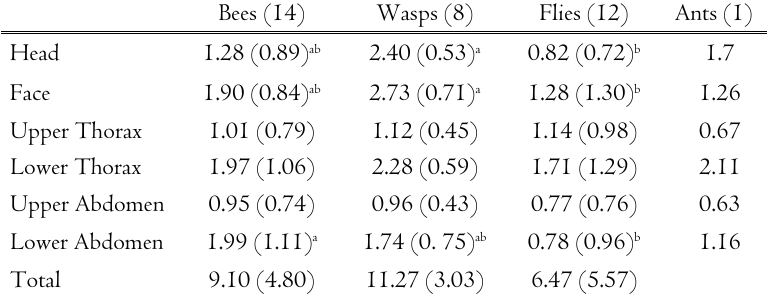
T ABLE 4. Mean (± sd) rating for pollen scores for bee, wasp and fly species for the six body parts surveyed. Pollen rating follows that in text: scale 0 (no pollen) to 4 (> 50 grains). Numbers in parentheses adjacent to taxa denote number of species in each group. Different superscripts within a row denote significant differences between taxa (P = 0.05; Kruskal-Wallis tests, multiple comparison correction tests). Ant species Formica obtusopilosa shown only for